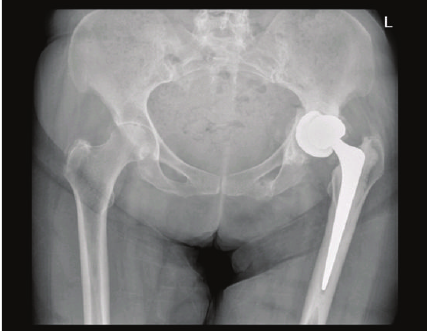
Figure 3: Pelvic radiograph taken after presentation with ongoing groin pain, showing fracture of the medial wall of the acetabulum with displacement of the acetabular component of the total hip replacement.